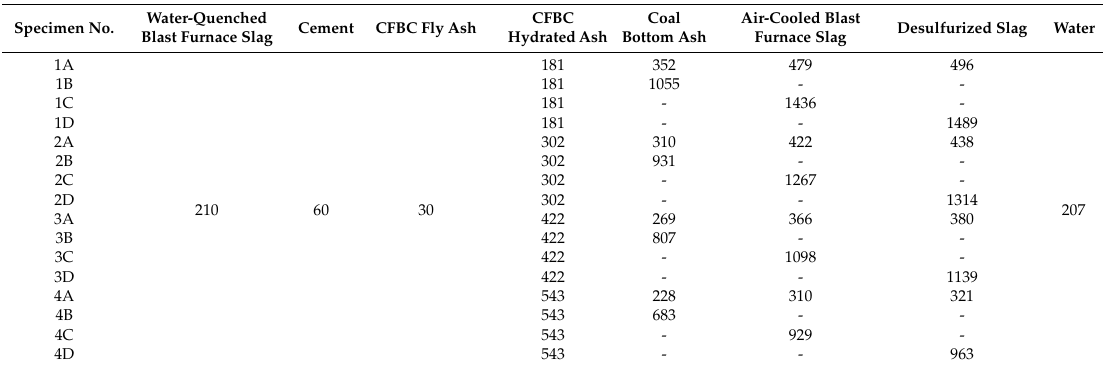
Table 2. Tested mixtures (kg/m 3